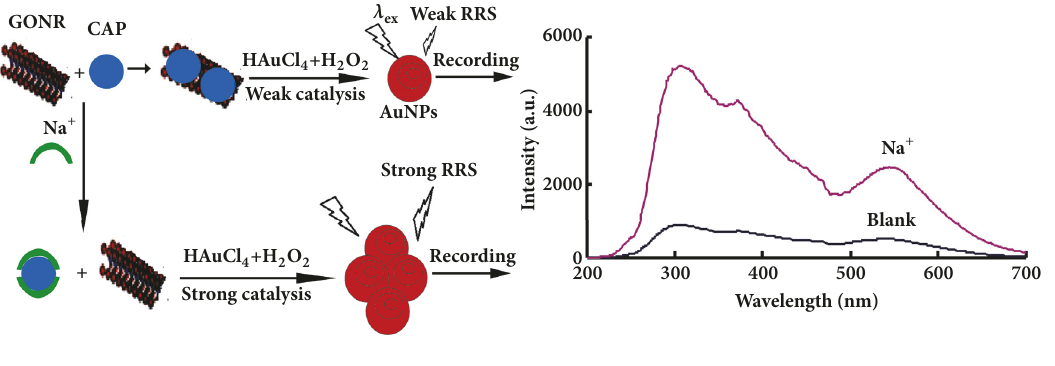
Figure 1: Principle of the RRS detection of Na + .